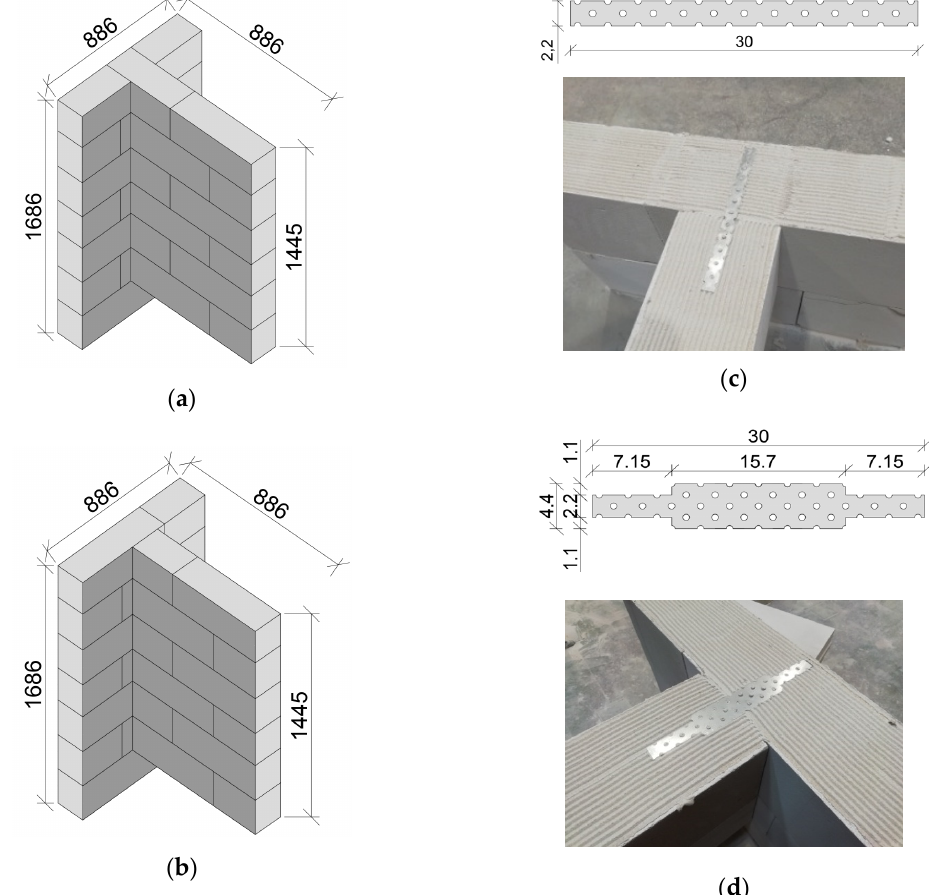
Figure 1. Geometry and details of test models and: ( a ) traditional masonry bond, P series, ( b ) walls with steel joints (B10 and BP10 series), ( c ) joining method with a punched flat bar, ( d ) joining method with a punched widened flat profile (mm).